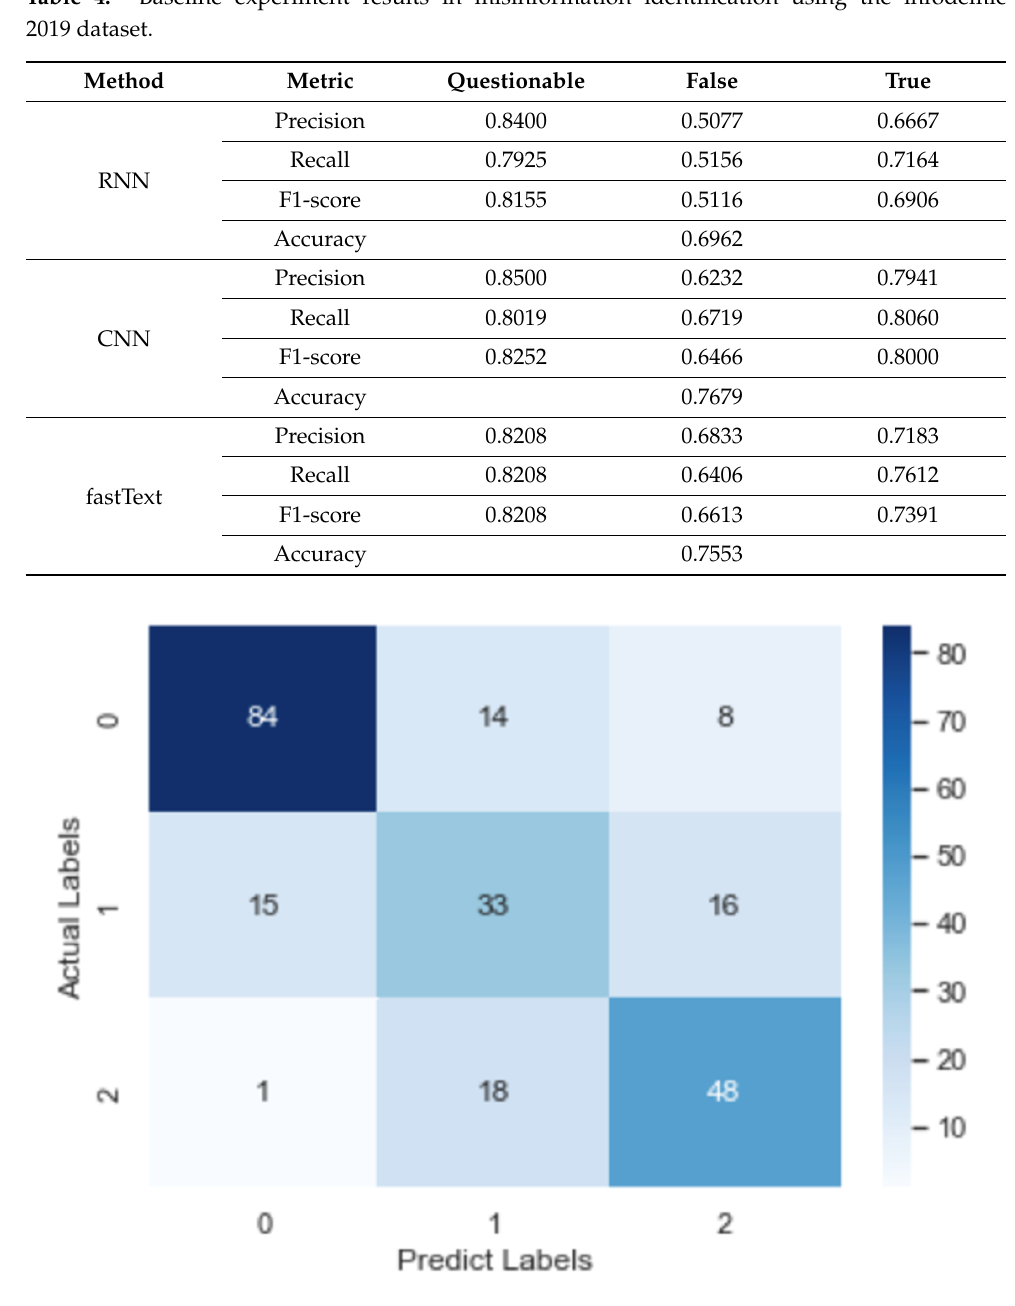
Figure 8. Confusion matrix of the RNN model.